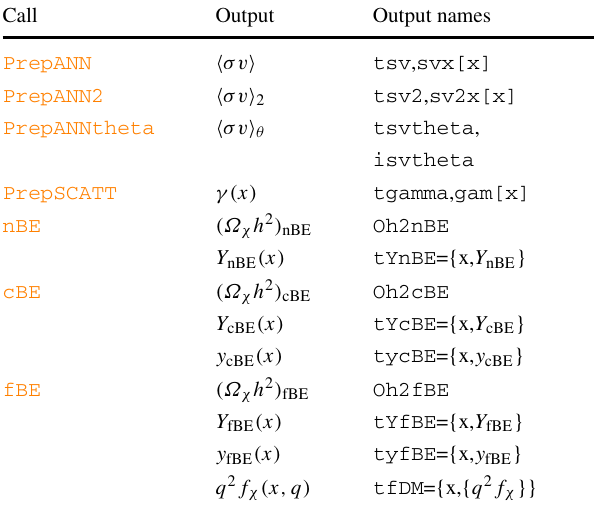
Table 3 Output summary of DRAKE routines. The last column lists the main output variables, tables, and functions stored in the kernel session memory after calling the routine. Cross-section outputs are in units of GeV − 2 and γ in GeV. All output names starting with ‘t’ are tables and names with an [x] dependence are interpolating functions based on these tables. The tables of the Boltzmann solvers contain all computed Y and y values from initial to final x except tfDM , which contains for memory reason only snapshots of the unity-normalized phase-space density at the initial, intermediate (when switching from momentum coordinates q A to q B , see Sect. 3.2) and final x value. The preparatory routines are stored in the file rates.wl and the Boltzmann solvers in nBE.wl , cBE.wl , and fBE.wl files in the DRAKE source